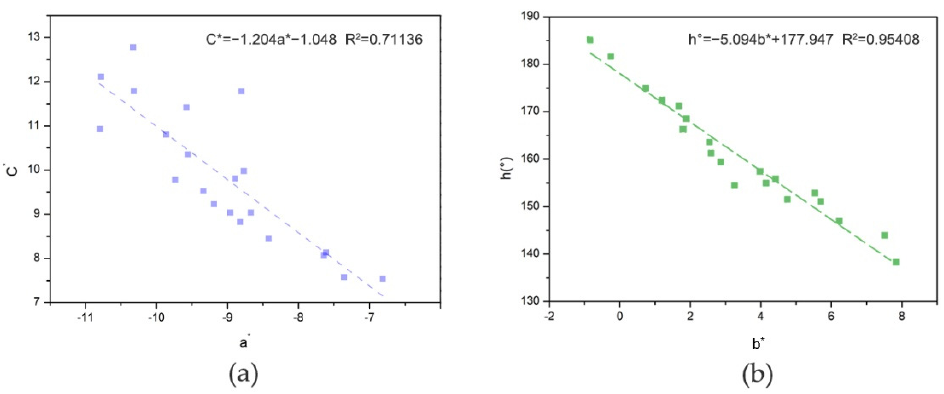
Figure 3. Plots of the correlation between ( a ) a* and C*, and ( b ) b* and h.